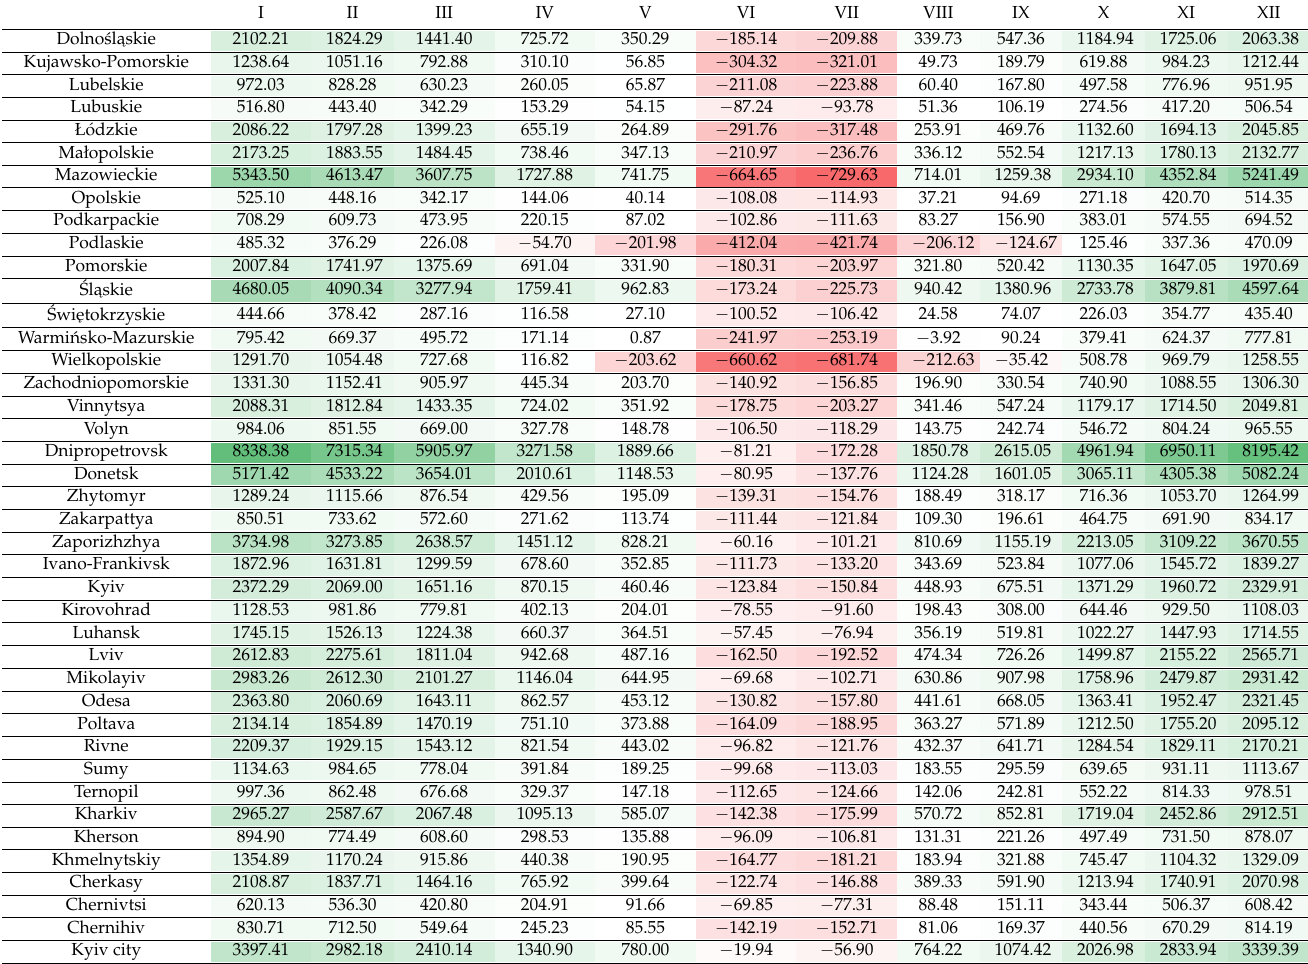
Table 1. Thermal energy balance (in TJ units) for individual months obtained with the use of the basic potential of biogas (red colors mean excess, green color means shortage). Source: Own